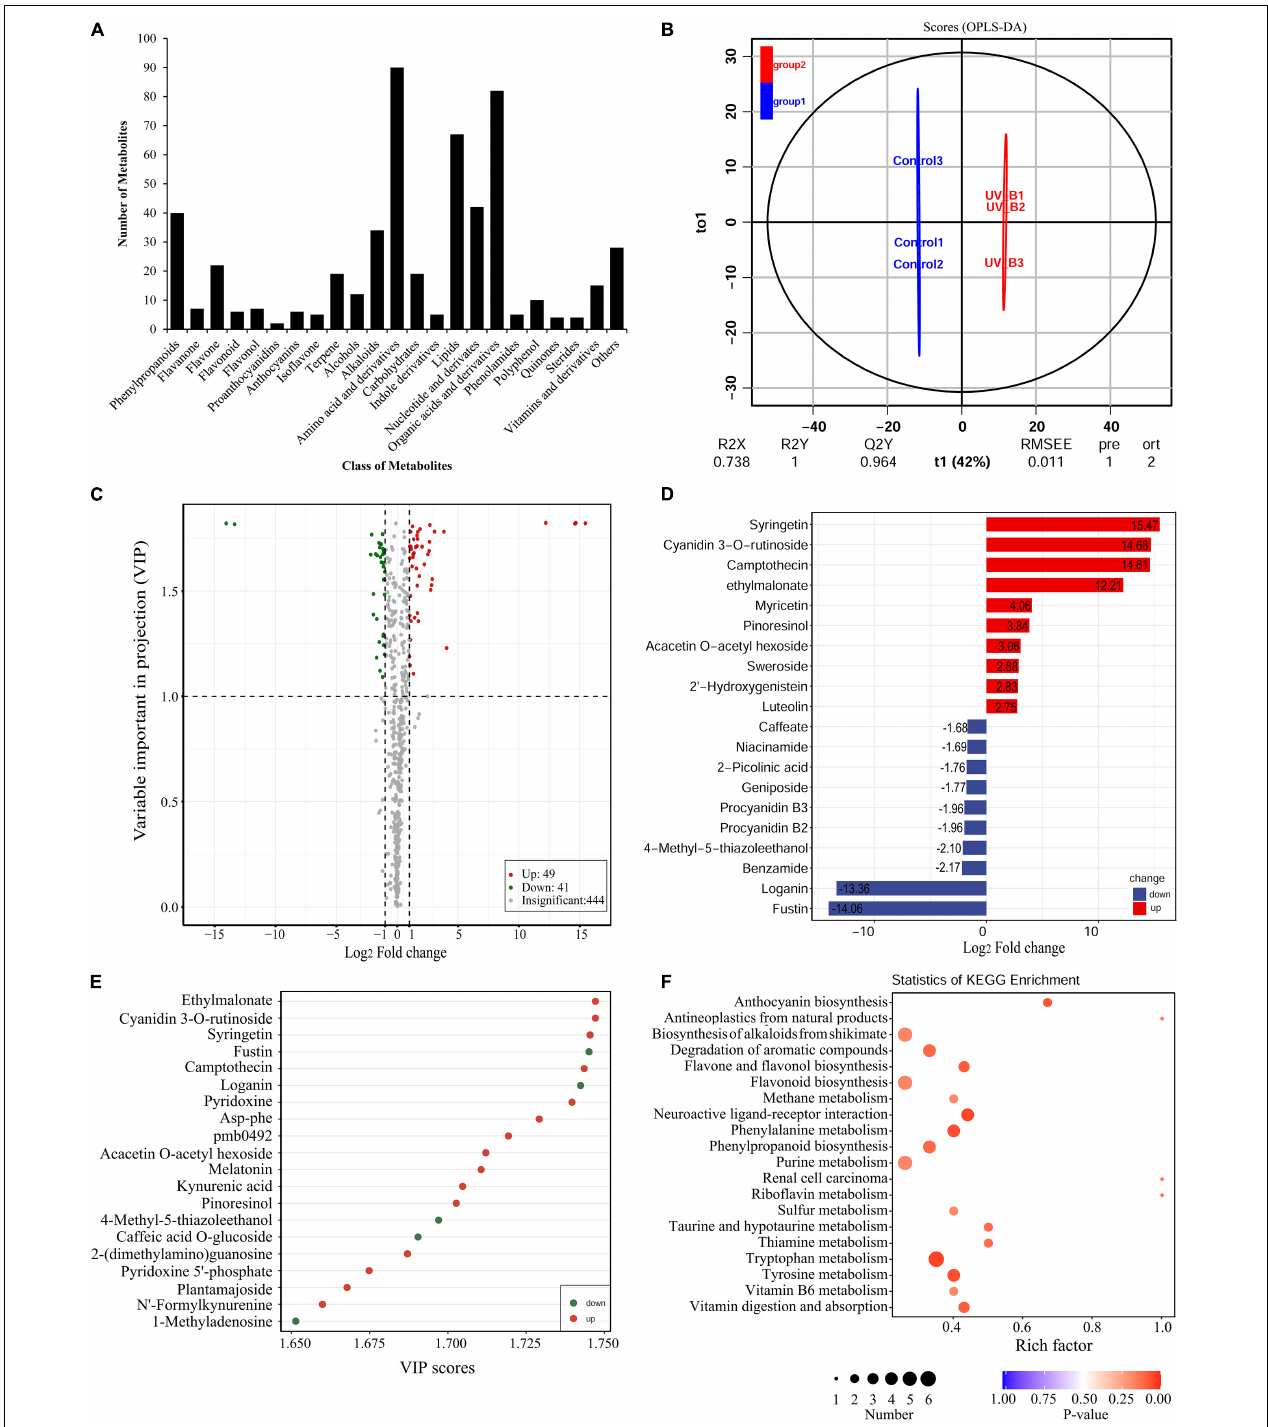
FIGURE 6 | Widely targeted metabolomic analysis of the Antarctic moss under UV-B radiation. (A) Statistical analysis of the classes of total metabolites. (B) The differences between UV-B radiation group and control group were calculated using OPLS-DA model. R 2 X and R 2 Y indicate the interpretation rate of X and Y matrix, respectively. Q 2 Y represents the prediction ability of the model. A value closer to 1 means that the model is more stable and reliable. In addition, Q 2 Y > 0.5 can be regarded as an effective model, and Q 2 Y > 0.9 is an excellent model. (C) The volcano plot showing the contents of metabolites and the statistical significance. Each point represents a metabolite. Horizontal ordinate indicates the fold change of metabolites between two groups, while VIP value represents significant difference in statistical analysis. (D) The fold change of the top 20 significantly changed metabolites (SCMs) between two groups. (E) The VIP scores of the top 20 SCMs between two groups. (F) Statistics of KEGG enrichment for the